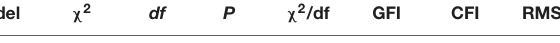
TABLE 2 | Resources and practices for inclusive education (RPIE): confirmatory factor analysis. Model